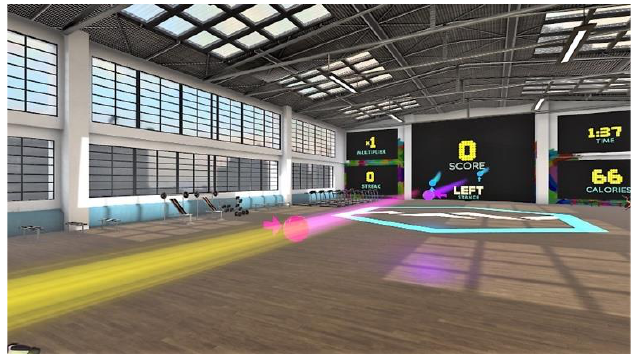
Figure 3. Screenshot of the exergaming proposed ( BOX VR ) placed in a gym.